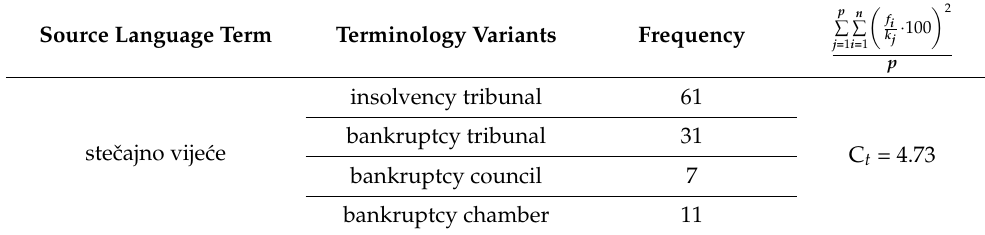
Table 3. Implementation of